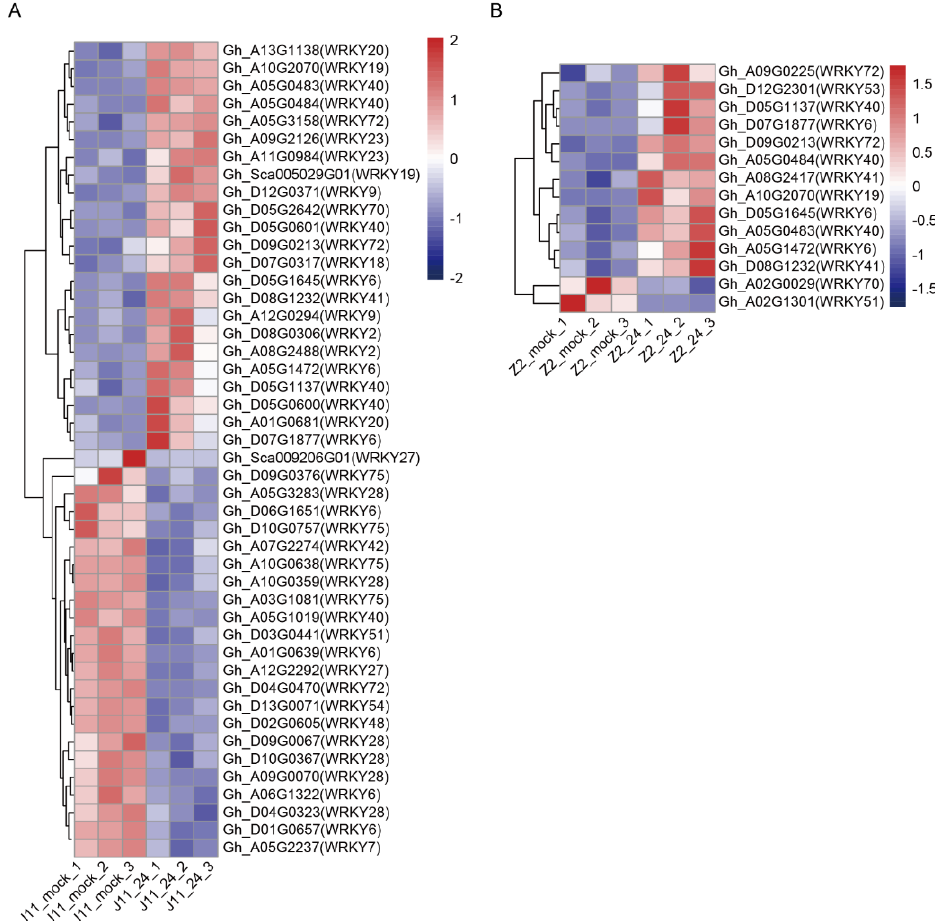
Figure 3. Expression profiling of WRKYs in response to V. dahliae stress. Hierarchical clustering of differentially expressed WRKYs in J11 ( A ) and Z2 ( B ). Red and blue colors show upregulation and downregulation, respectively. The original expression values of the WRKYs were normalized using Z-score. The signal intensity ranges from − 2 to 2, as the corresponding color also changes from blue to red.